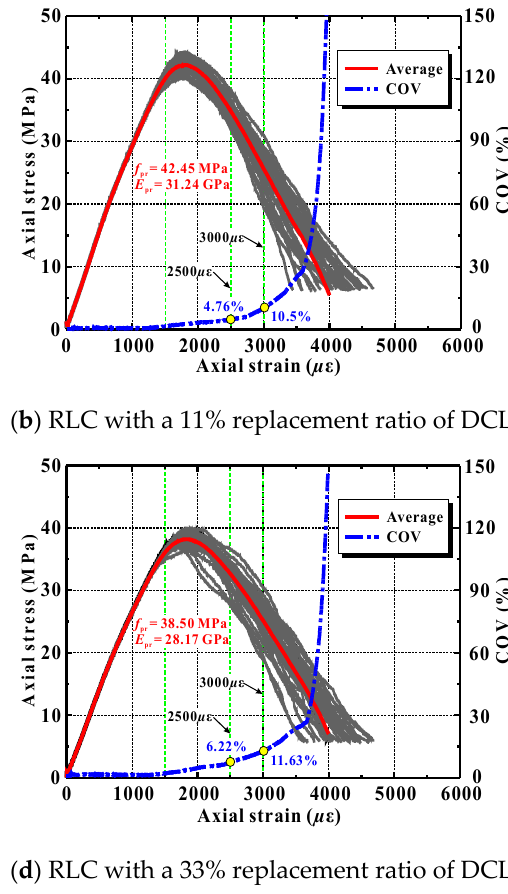
Figure 11. Mean stresses and their standard deviations. A total of 420 concrete samples were simulated to study the influence of the random distribution of DCLs and coarse aggregates on recycled lump concrete’s performance in compression. The main variables were the relative strength of the new and old concrete, and the lump replacement ratio. Table 8 presents the details of these variables. Table 8. Parameter values simulated. DCL—demolished concrete lump. Parameter